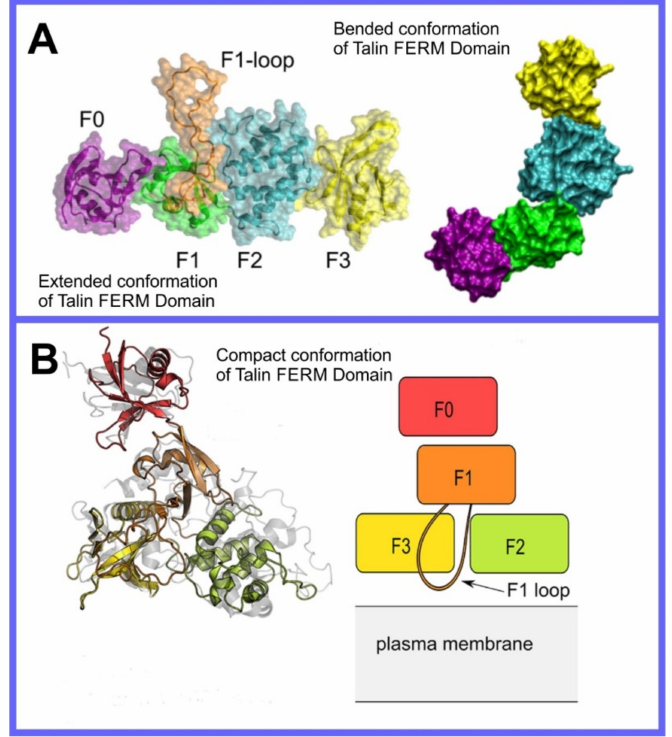
Figure 26. Conformation of talin FERM domain ( A ) extended conformation from crystal structure (PBD ID 3IVF) and after CG simulations [1059], ( B ) compact conformation